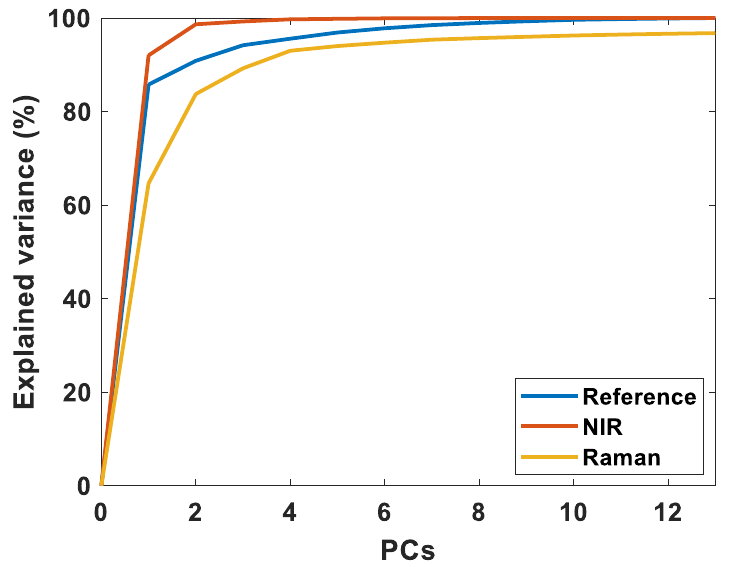
Figure 1. The explained variance of the reference data, NIR spectra, and Raman spectra, respectively. This figure only shows 13 components, because only 13 FAs are included in the data analysis.